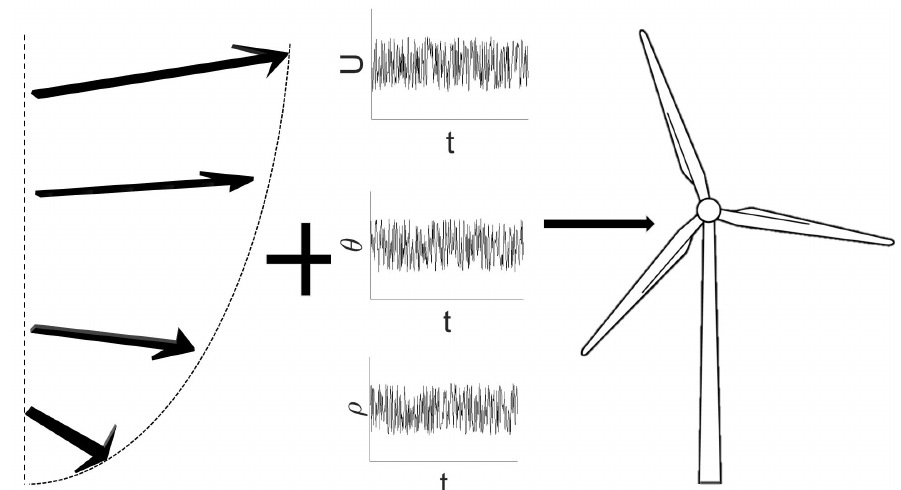
Figure 2. Wind veer and shear at inflow results in different values of yaw error ( θ ) and wind speed at different heights. Turbulence also causes fluctuations over mean values of wind speed, yaw error and density. All of these variables are used for predicting power generation by the wind